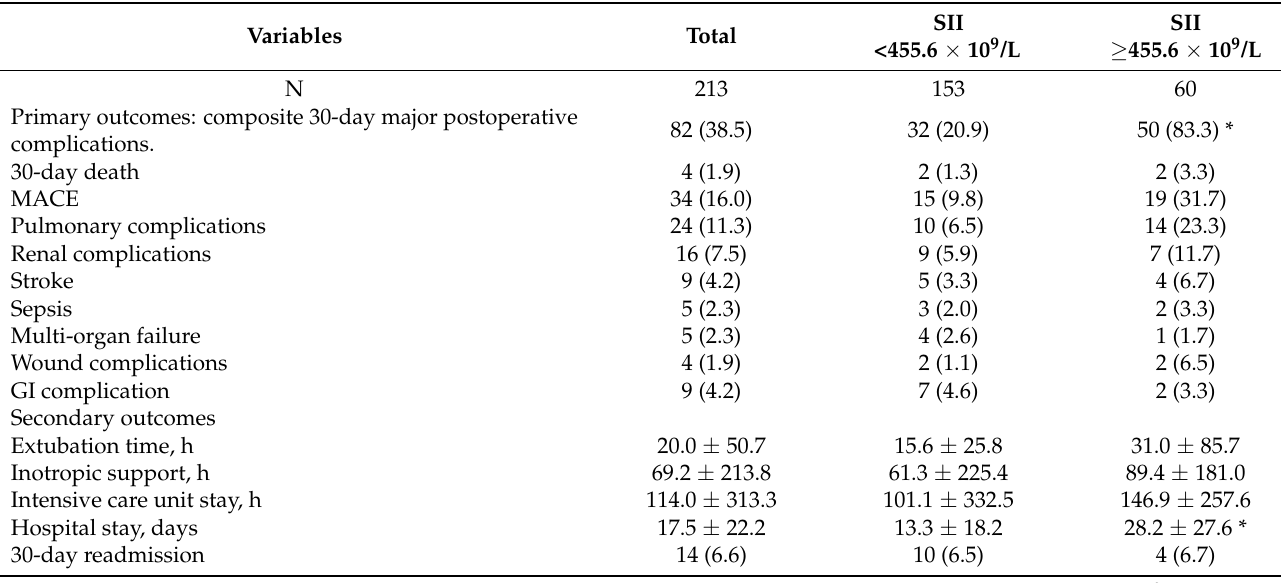
Table 2. Postoperative outcomes for SII